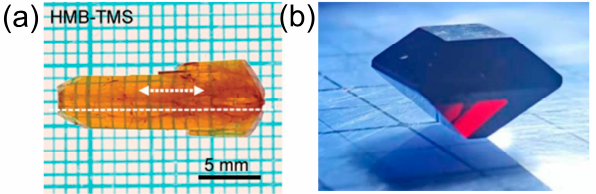
Figure 20. Crystal photos of ( a ) HMB-TMS [47], and ( b ) MBI [55].